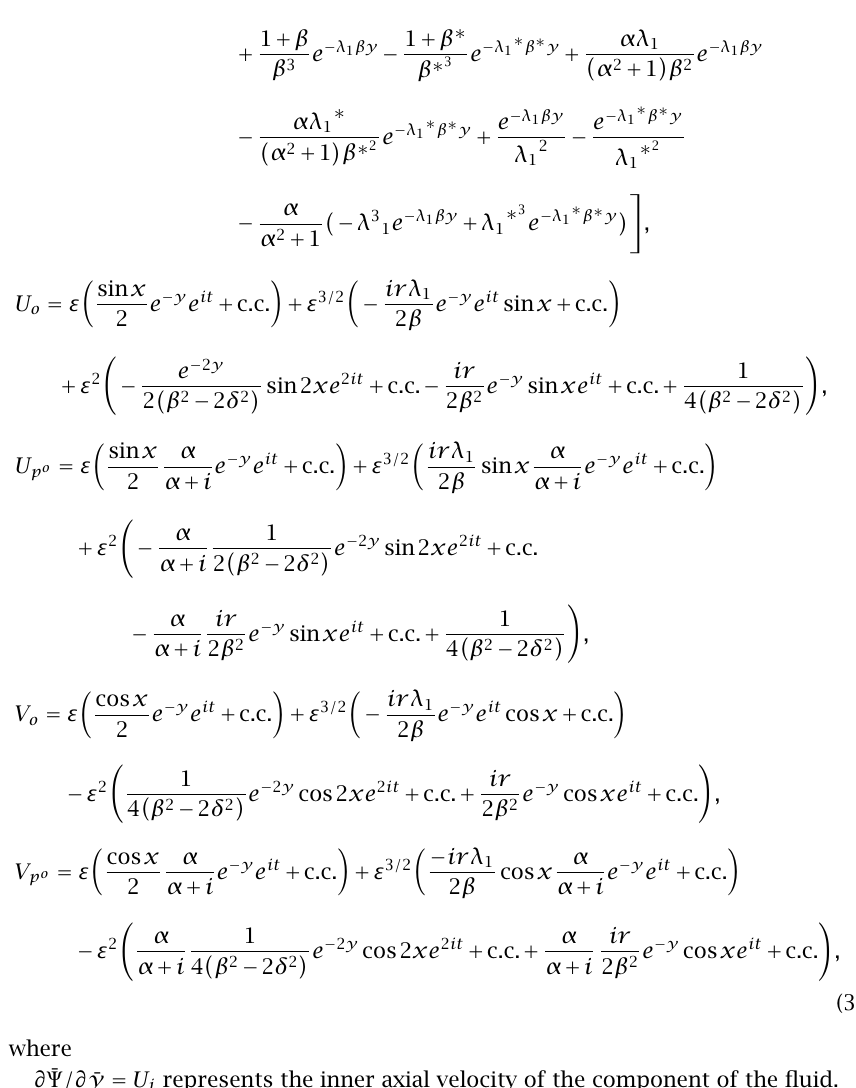
∂ ¯ Ψ /∂ ¯ y = U i represents the inner axial velocity of the component of the fluid. ∂ ¯ Ψ /∂ ¯ y = U represents the inner axial velocity component of dust particles. p i − ∂ ¯ Ψ /∂x = V i represents the inner transverse velocity component of the fluid. − ∂ Ψ p /∂x = V represents the inner transverse velocity component of dust. p i U is represents the inner steady axial velocity component of the fluid. U represents the inner steady axial velocity component of dust. p is V is represents the inner steady transverse velocity component of the fluid. V represents the inner steady transverse velocity component of the dust. p is ∂ Ψ /∂y = U o represents the outer axial velocity component of the fluid. ∂ Ψ p /∂y = U p o represents the outer axial velocity of the component of the dust. − ∂ Ψ /∂x = V o represents the outer transverse velocity component of the fluid. − ∂ Ψ p /∂x = V p o represents the outer transverse velocity component of the